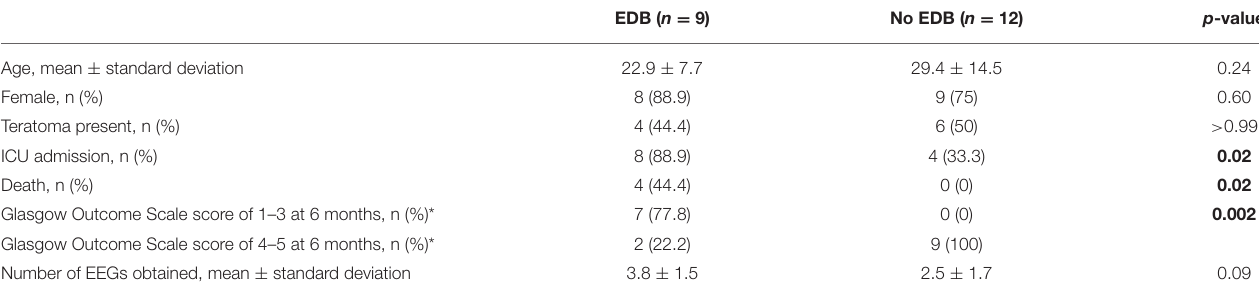
TABLE 2 | Patient demographics in those with anti-NMDAR encephalitis with and without extreme delta brush on